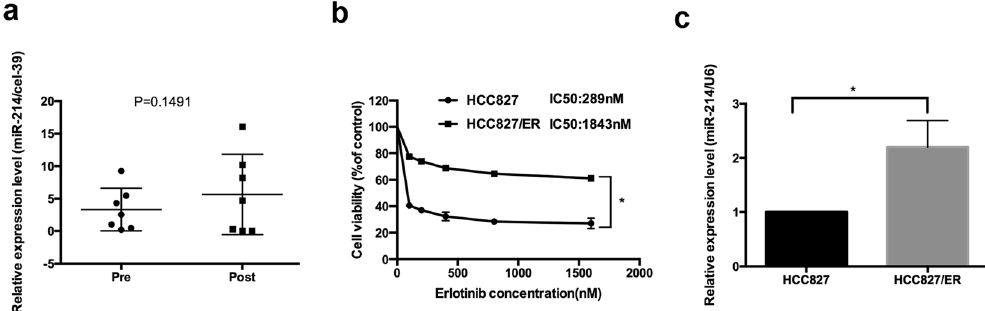
Figure 1. miR-214 expression in HCC827 and HCC827/ER cells and in the plasma of NSCLC patients pre- and post-treatment with EGFR-TKIs. ( a ) qRT-PCR assay revealed an increase in the miR-214 expression in the plasma of NSCLC patients with acquired EGFR-TKI resistance than in NSCLC patients prior of EGFR-TKI therapy ( P = 0.398). ( b ) MTS assay showed a 289 nM IC 50 for HCC827 cells and a 1,843 nM erlotinib IC 50 for HCC827/ER cells. * P < 0.05; ( c ) qRT-PCR assay showed significant up-regulation of miR-214 expression in HCC827/ER cells than in HCC827 cells. * P < 0.05; All data are expressed as mean ± SD from three